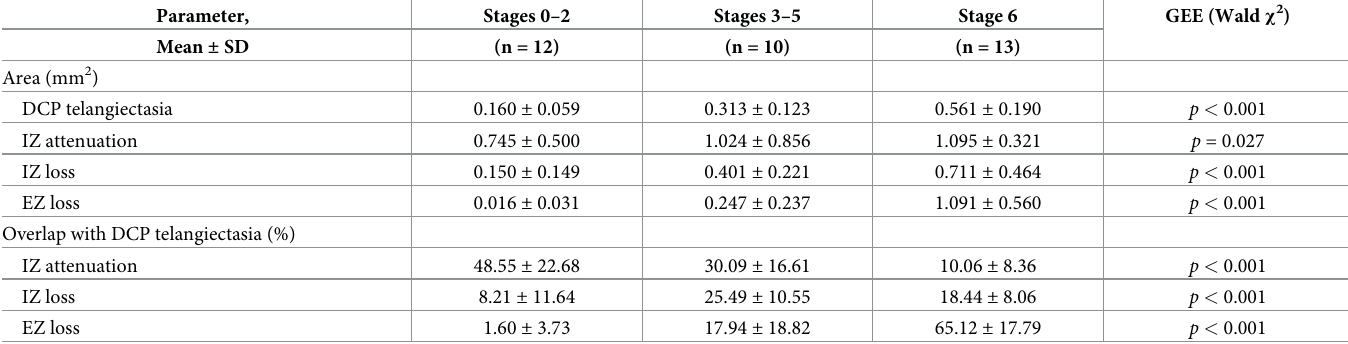
Table 3. By-group analysis of DCP telangiectasia area, photoreceptor defect areas and their overlap percentages with DCP telangiectasia by pooled OCT-based MacTel stages.